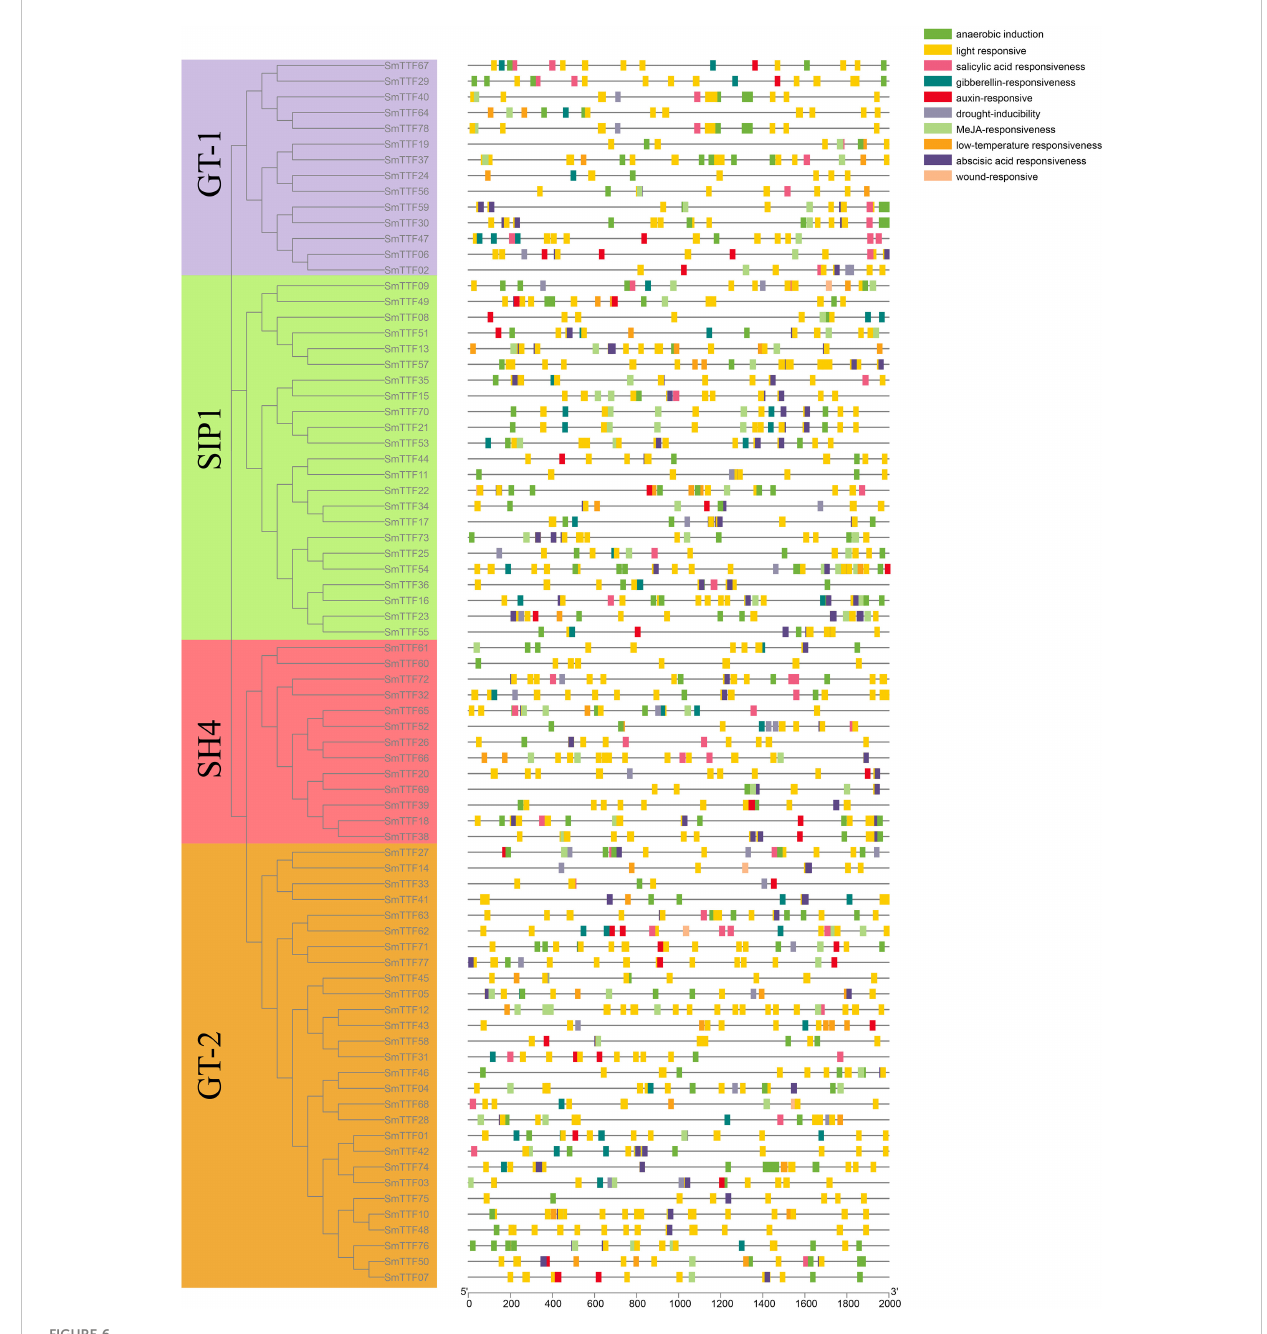
FIGURE 6 Distribution of predicted cis-acting elements in the promoter region. Elements are indicated as rectangles, and other sequences are indicated as